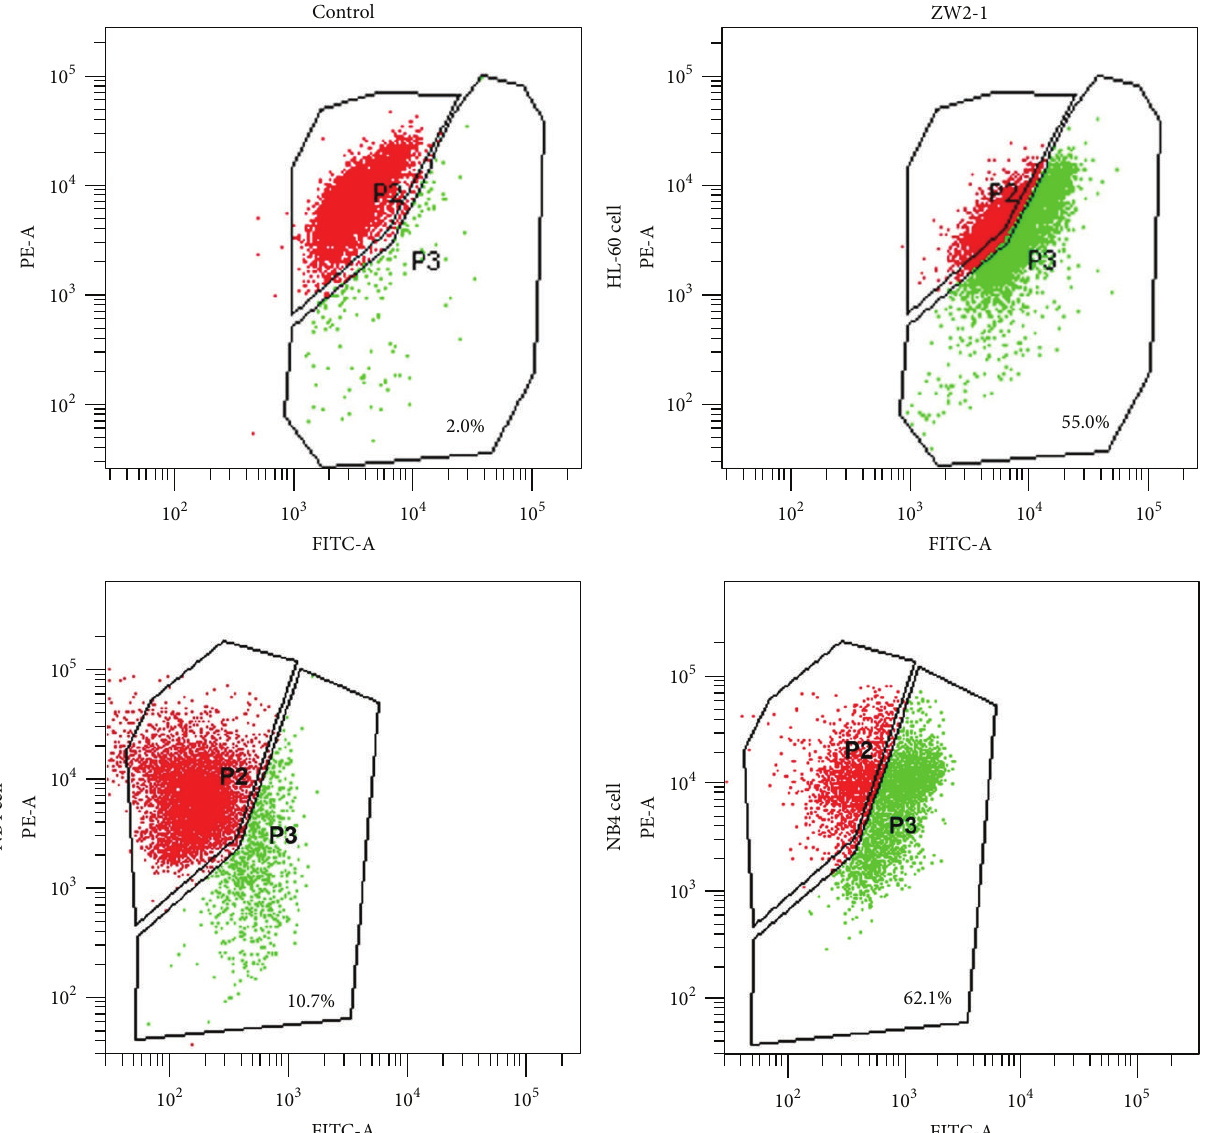
Figure 3: Effects of ZW2-1 on mitochondria membrane electrochemical potential of HL-60 cells. HL-60 cells were stained with JC-1 dye (P2: aggregated JC-1, red fluorescence (PE); P3: monomeric JC-1, green fluorescence (FITC)) which was measured by flow cytometry. The value represents the average percentage of cells in each gate ( 𝑛 = 3